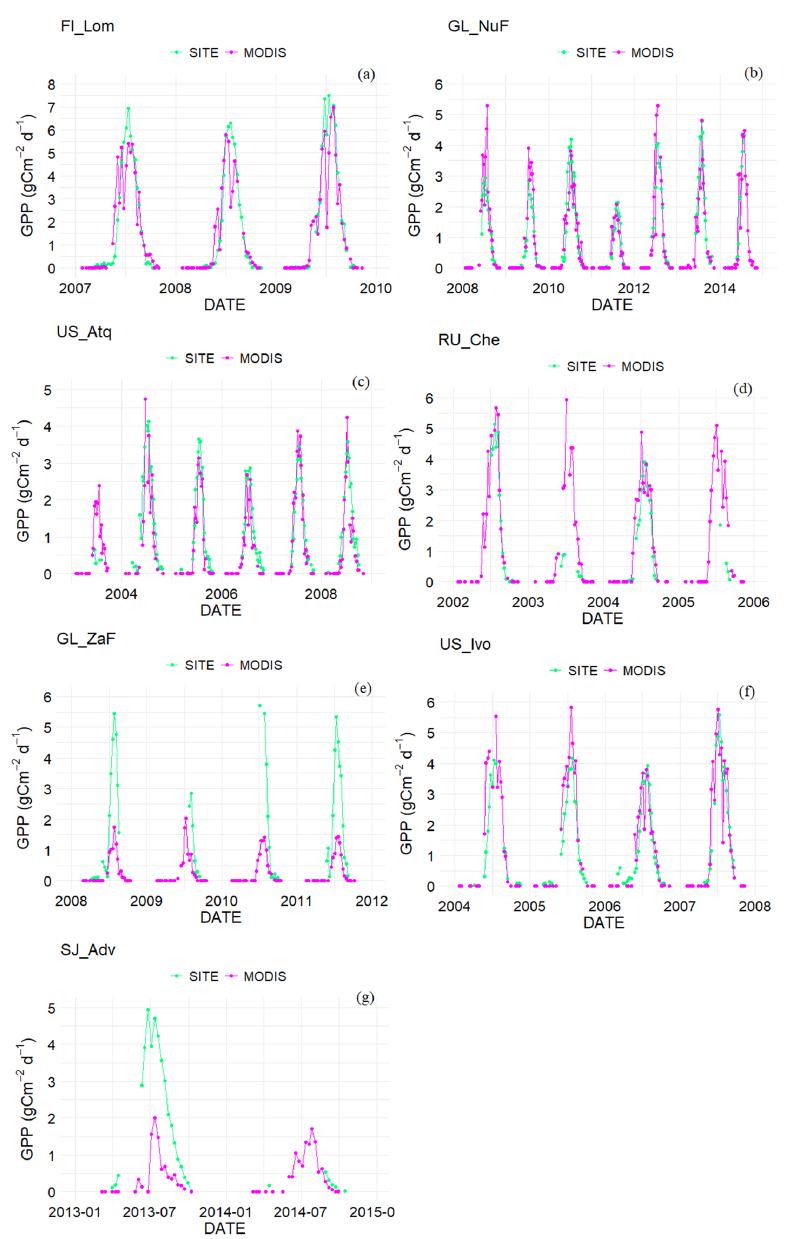
Figure 2. Time series comparison between site-based GPP and MOD17A2H over wetland sites, ( a – g ) refers to FI_Lom, GL_NuF, US_Atq, RU_Che, GL_ZaF, US_Ivo and SJ_Adv, respectively.